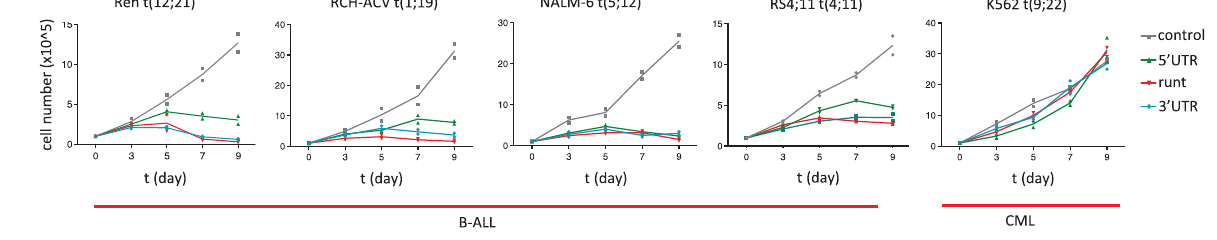
engraftment. d Bioluminescence imaging at 2 and 4 weeks (end point) after injec- tionofsamplestransducedwithshRNAstargeting RUNX1 orcontrolshRNA(see c ). e Plotsshowingendpointanalysisofleukemicengraftmentoftwopatientsamples with indicated cytogenetics transduced with non-targeting or RUNX1 -shRNAs. Human (CD19 + ), gated on human CD45 + cells, were assessed for the proportion of shRNA-transduced (GFP + ) vs wild-type GFP - cells (Supplementary Fig. 7c). Data 67,642, df = 5, p < 2.2e − 16) ( b ). Two-tailed, unpaired t -test revealed a signi fi